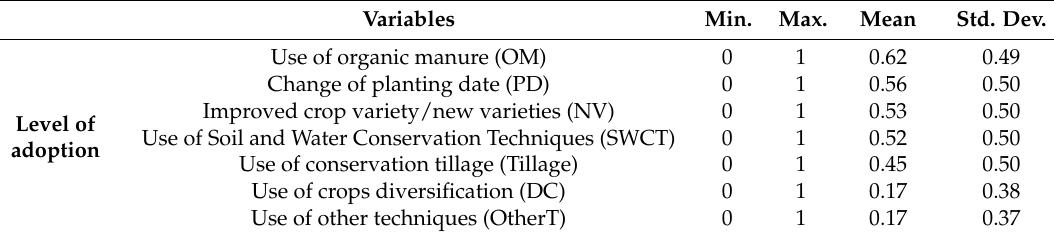
Table 3. Description of Dependent Variables (Multivariate Probit